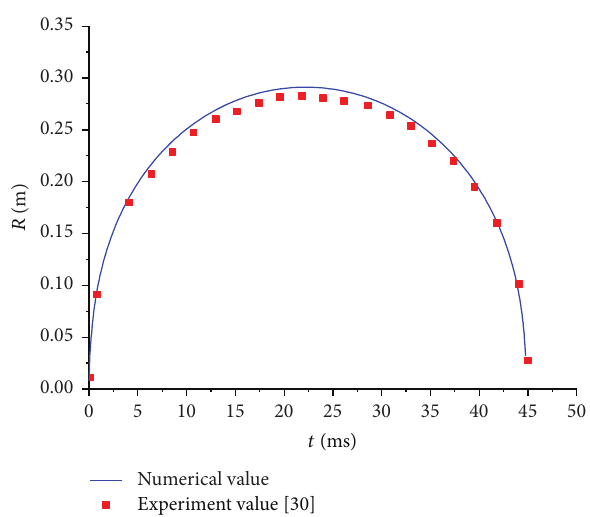
Figure 6: Comparison curves of bubble radius along with time during bubble pulsing.